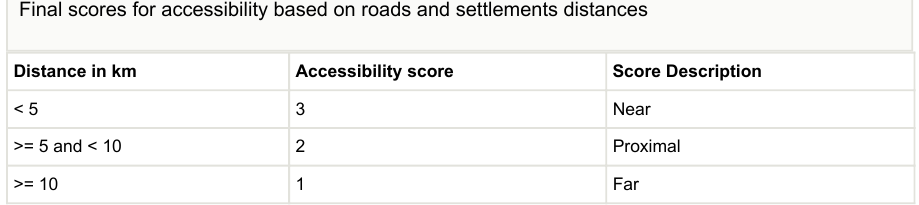
Table 6. Final scores for accessibility based on roads and settlements distances